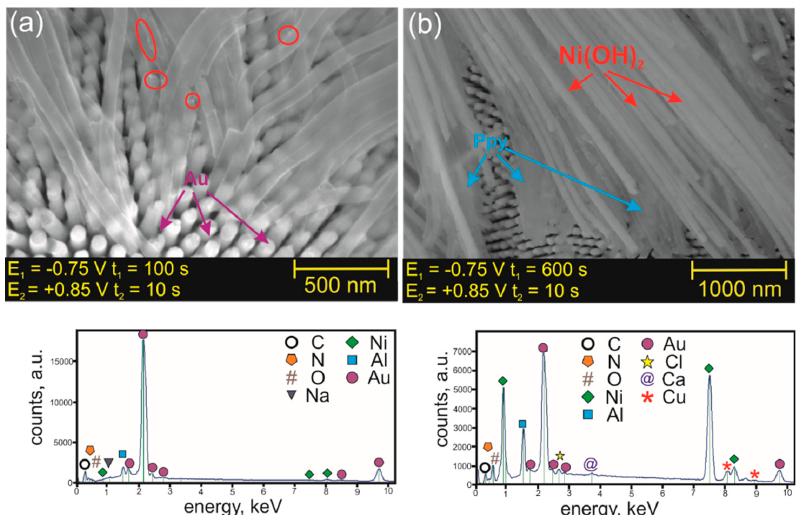
Figure 4. FE-SEM images (top images) together with their EDS analyses (bottom images) of hybrid PPy-Ni(OH) 2 nanowires formed at different durations of the cathodic potential pulse. The duration of the cathodic pulse was ( a ) 100 s and ( b ) 600 s. The duration of the anodic pulse was 10 s for (a) and (b). The presence of Ni(OH) 2 nanoparticles is marked with red ellipses.